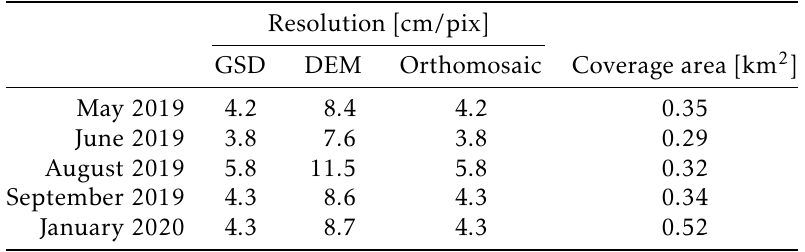
Table A1: Survey data for the five UAV campaigns between May 2019 and January 2020.